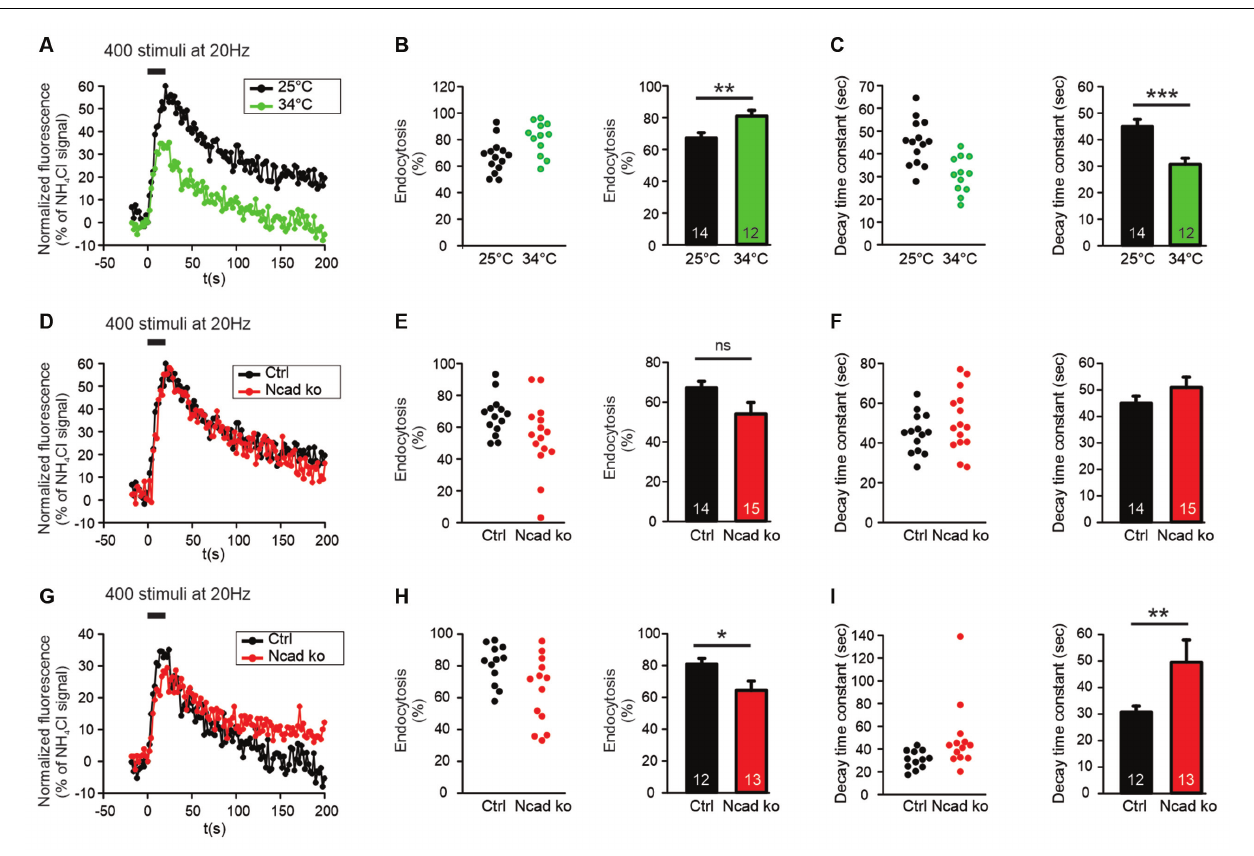
FIGURE 2 | N-cadherin knockout resulted in impaired synaptic vesicle endocytosis at near physiological temperature (34 ◦ C) at axonal release sites. (A–C) Increasing temperature from room (25 ◦ C) to near physiological (34 ◦ C) temperature enhanced synaptic vesicle endocytosis at axonal release sites. n = 14 (25 ◦ C)/12 (34 ◦ C) cells, total SypHy puncta analyzed were 299/191. (A) Example time courses of mean SypHy fluorescence intensities (all puncta per cell averaged, normalized to NH 4 Cl signal) in response to 400 stimuli at 20 Hz at room temperature (25 ◦ C, black) and at 34 ◦ C (green). (B) Quantitative analysis of endocytosis at 90 s after the end of stimulation (SypHy signal loss as % of maximal SypHy signal) in individual neurons ( left ), and means ± SEM at room and near physiological temperature ( right ). P = 0.010. (C) Quantification of SypHy signal decay time constant (tau, monoexponential fit) in individual neurons ( left ), and means ± SEM at room and near physiological temperature ( right ). P < 0.001. (D–F) Conditional knockout of N-cadherin did not significantly affect synaptic vesicle endocytosis at room temperature (25 ◦ C). n = 14 (control)/15 (knockout) cells, total SypHy puncta analyzed were 299/370. (D) Example time courses of mean SypHy fluorescence intensities (all puncta per cell averaged, normalized to NH 4 Cl signal) for control (co-expressing DsRed2 + SypHy; black) and N-cadherin knockout (co-expressing DsRed2 + SypHy + CreEGFP; red) neurons at 25 ◦ C. (E) Quantitative analysis of endocytosis at 90 s after the end of stimulation (SypHy signal loss as % of maximal SypHy signal) in individual neurons ( left ), and means ± SEM for control and N-cadherin knockout neurons ( right ). (F) Quantification of SypHy signal decay time constant (tau, monoexponential fit) in individual neurons ( left ), and means ± SEM for control and N-cadherin neurons ( right ). (G–I) Conditional knockout of N-cadherin resulted in significantly impaired vesicle endocytosis at near physiological temperature (34 ◦ C). n = 12 (control)/13 (knockout) cells, total SypHy puncta analyzed were 191/237. (G) Example time courses of mean SypHy fluorescence intensities (all puncta per cell averaged, normalized to NH 4 Cl signal) for control (black) and N-cadherin knockout (red) neurons at 34 ◦ C. (H) Quantitative analysis of endocytosis at 90 s after the end of stimulation (SypHy signal loss as % of maximal SypHy signal) in individual neurons ( left ), and means ± SEM for control and N-cadherin knockout neurons ( right ). P = 0.028. (I) Quantification of SypHy signal decay time constant (tau, monoexponential fit) in individual neurons ( left ), and means ± SEMs for control and N-cadherin knockout neurons ( right ). P = 0.01. ns: non-significant, * P < 0.05, ** P < 0.01, *** P < 0.001, Student’s t -test (B,C,E–G) . Whenever the normality test failed, Mann-Whitney’s test on ranks was performed (I) . Data shown in (A–C) are the same as control data in (D–F) and (G–I) . n (cells) is indicated on